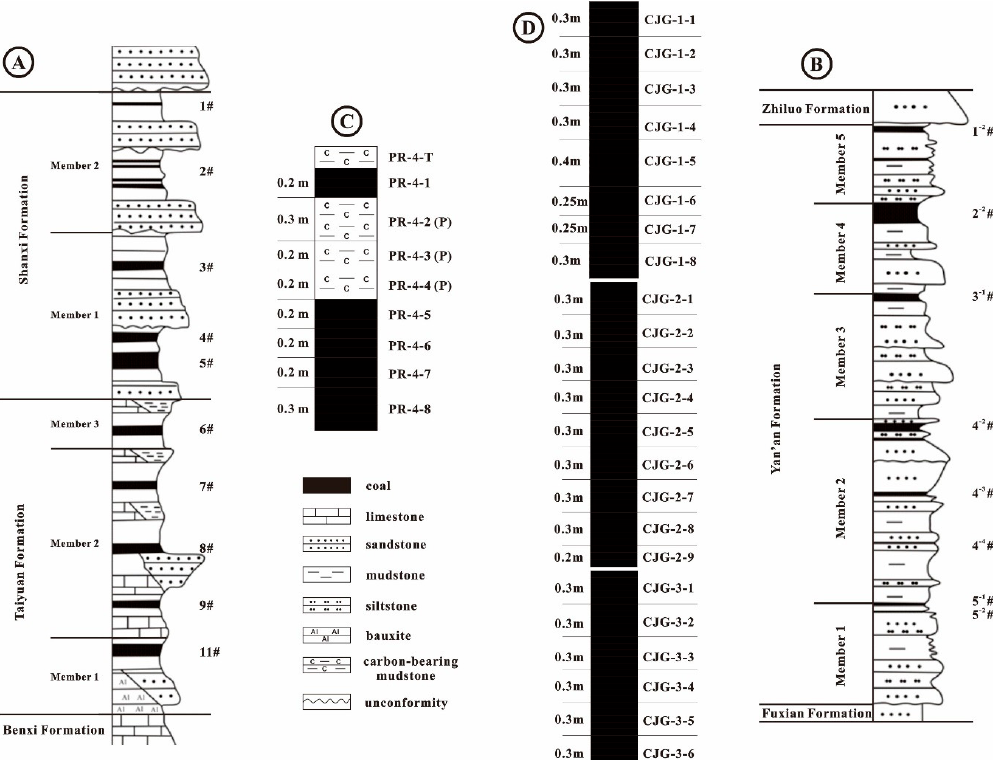
Figure 2. Sedimentary sequence of the Taiyuan and Shanxi Formations ( A ) and Yanan Formation ( B ) in the Ordos Basin [35] and sampling location from the Puran ( C ) and Cuijiagou ( D ) underground coal mines